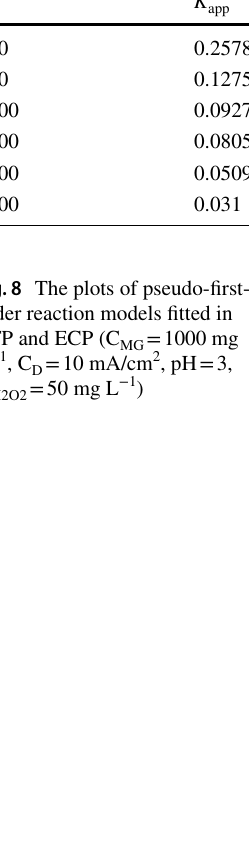
Table 2 Kinetic parameters for degradation of MG at differ- ent initial concentrations by EFP (CD = 10 mA/cm 2 , pH = 3, C H2O2 = 50 mg/L − 1) Malachite Green concentration(mg/L)